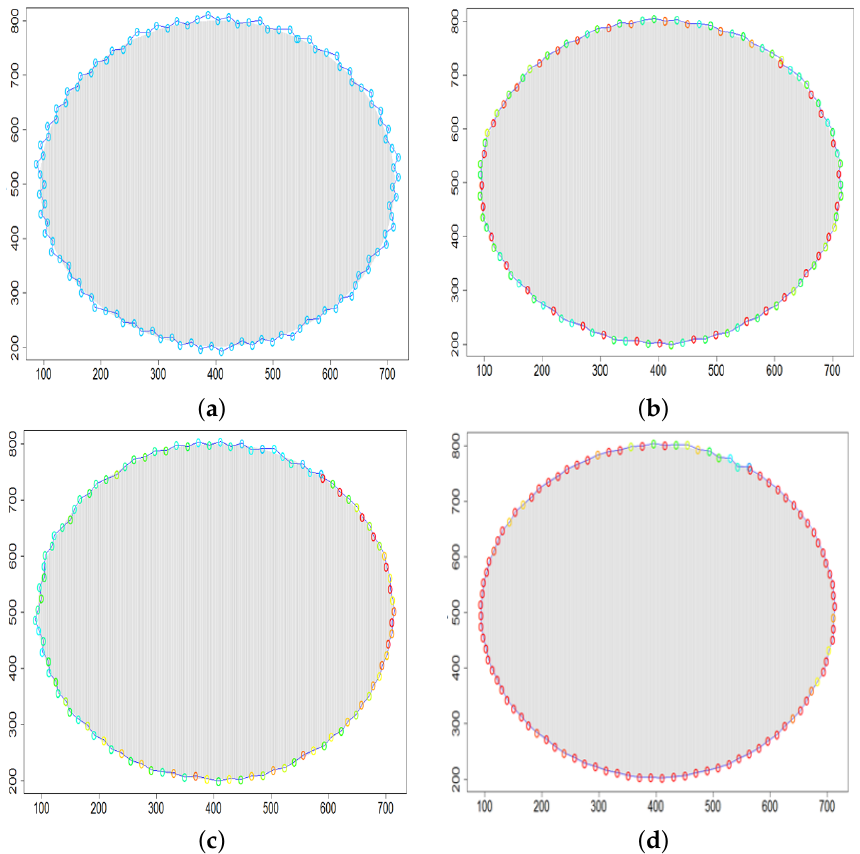
Figure 9. Successive D P positions during cloud boundary tracking calculated for four variants of m (cid:101) χ updating procedures: ( a ) variant I, ( b ) variant III, ( c ) variant IV, ( d ) variant V; simulation scenario Cloud 1 . The colors of the points correspond to different values of (cid:101) χ .